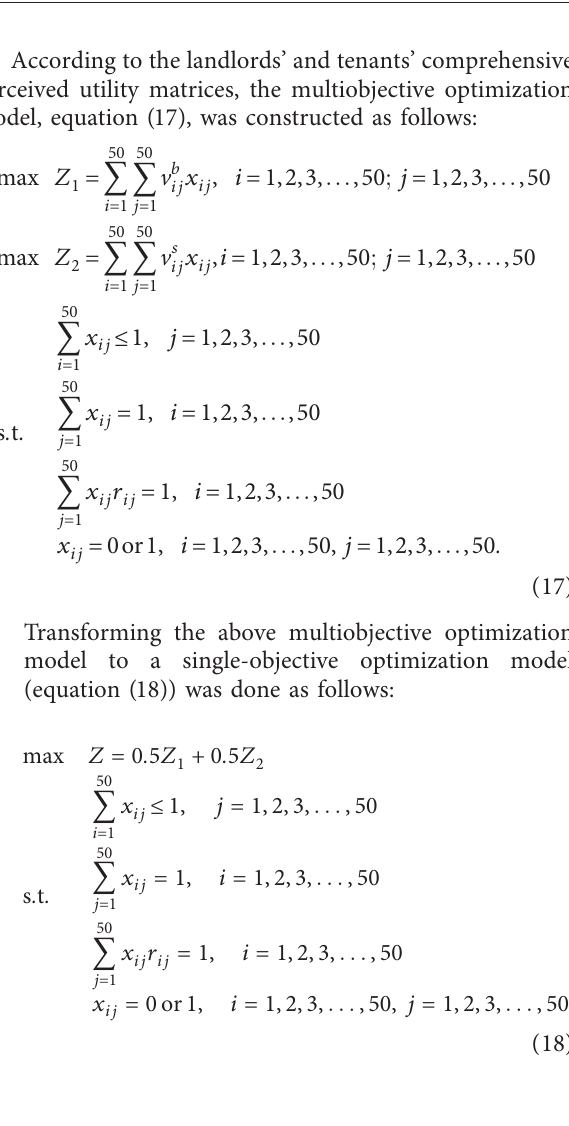
Table 19: Comprehensive perceived utility matrix V � [ v b tenants. v b